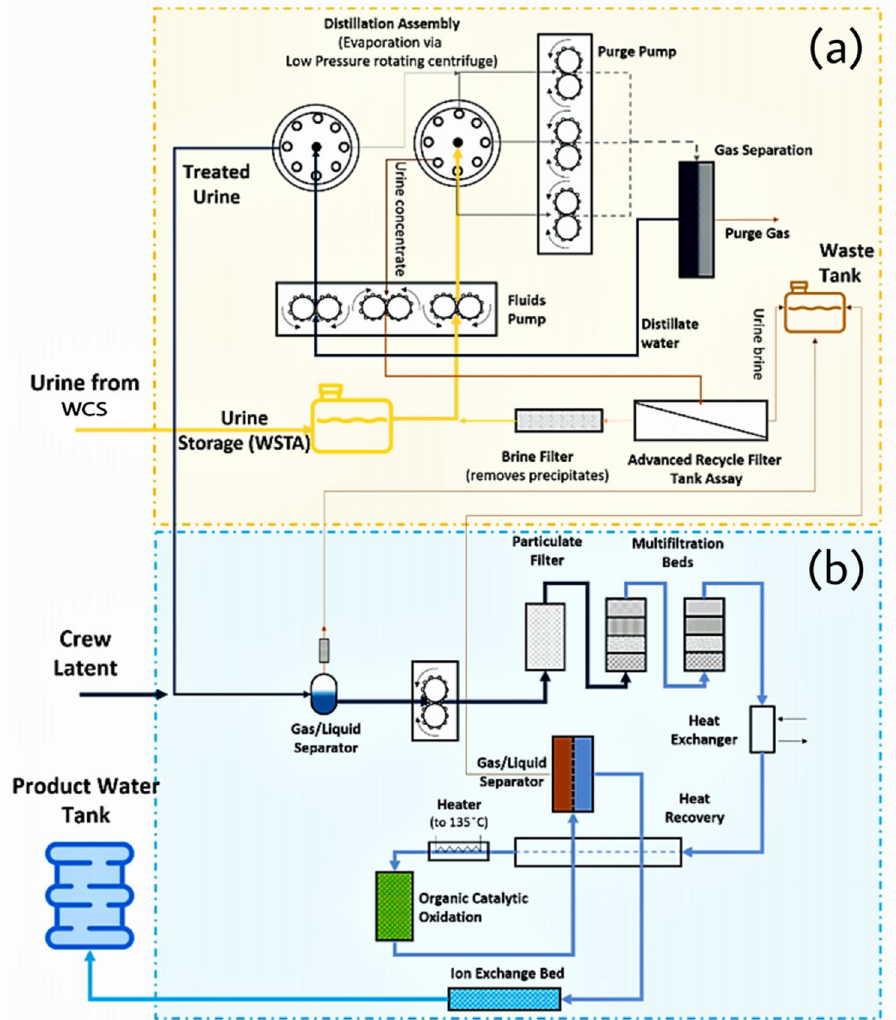
Fig. 10 Schematic block diagram showing all a the accessories of the urine processor assembly (UPA), and b the water processor assembly (WPA) used by